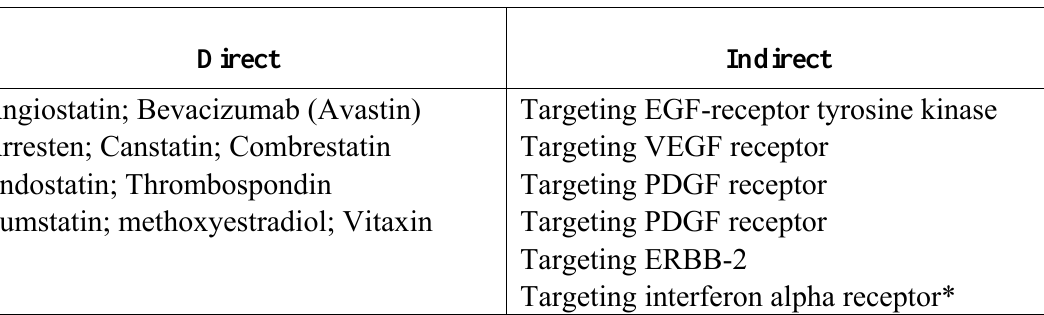
Table 1. Direct and indirect angiogenesis inhibitors.